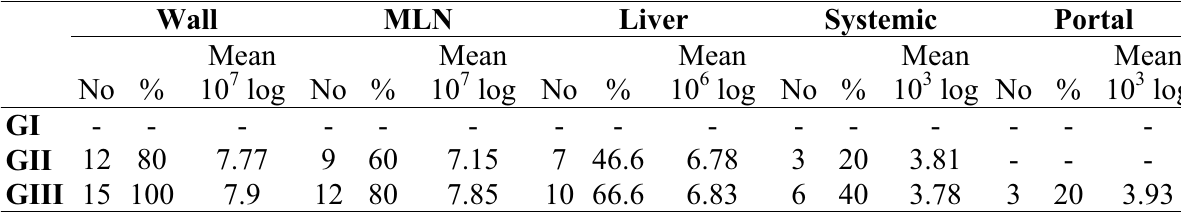
TABLE 2 - Frequency and density of bacterial translocation in the tissues among the studied groups